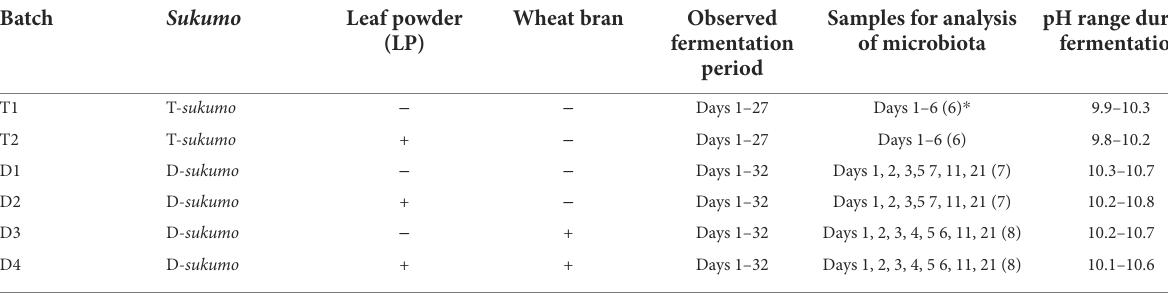
TABLE 1 Preparation and maintenance procedures for six batches of sukumo fermentation fluids. Batch Sukumo Leaf powder Wheat bran Observed (LP)